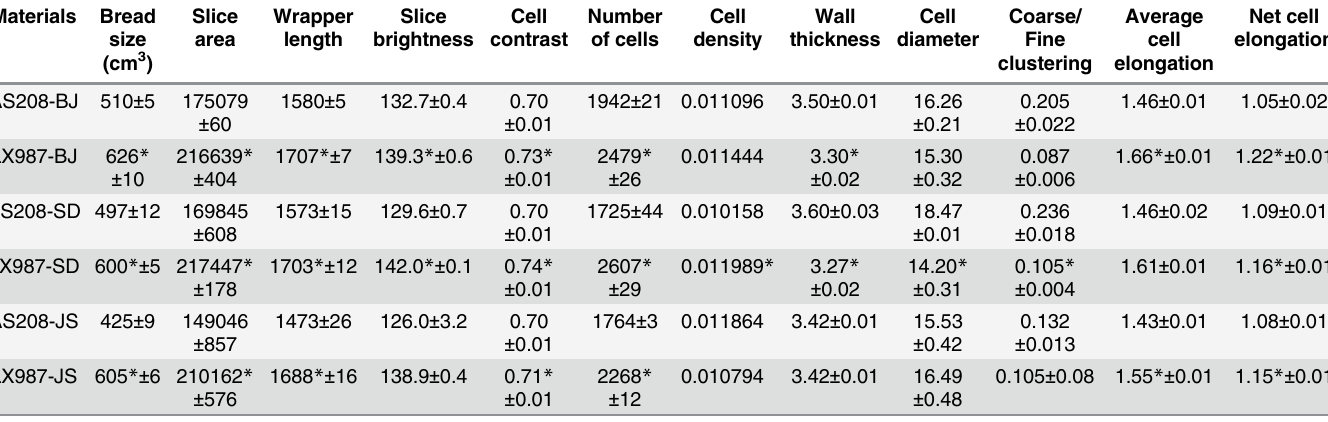
Table 5. Bread size and slices C-Cell parameters between AS208 and LX987 produced in different regions. Materials Bread size (cm 3